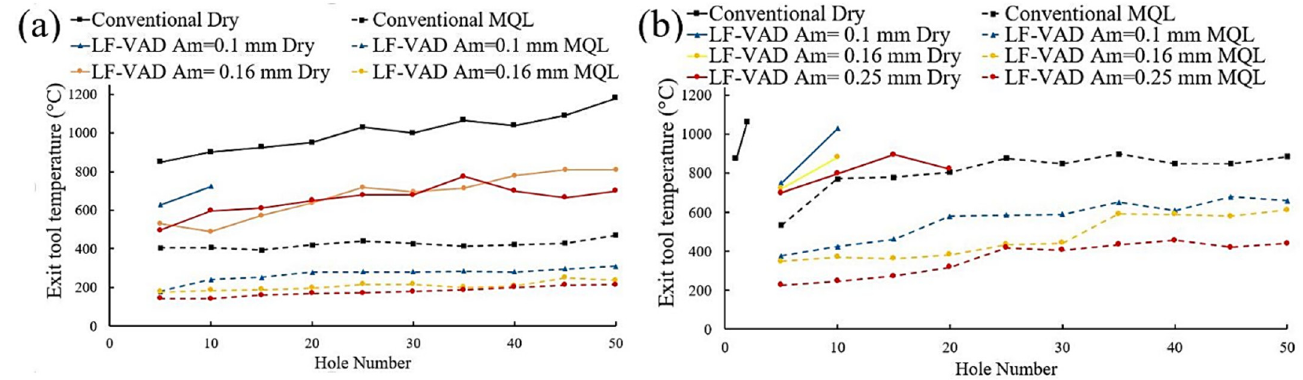
Figure 5. Effect of coolant medium on the cutting temperature for ( a ) N = 2000 rpm ( b ) N = 3000 rpm.